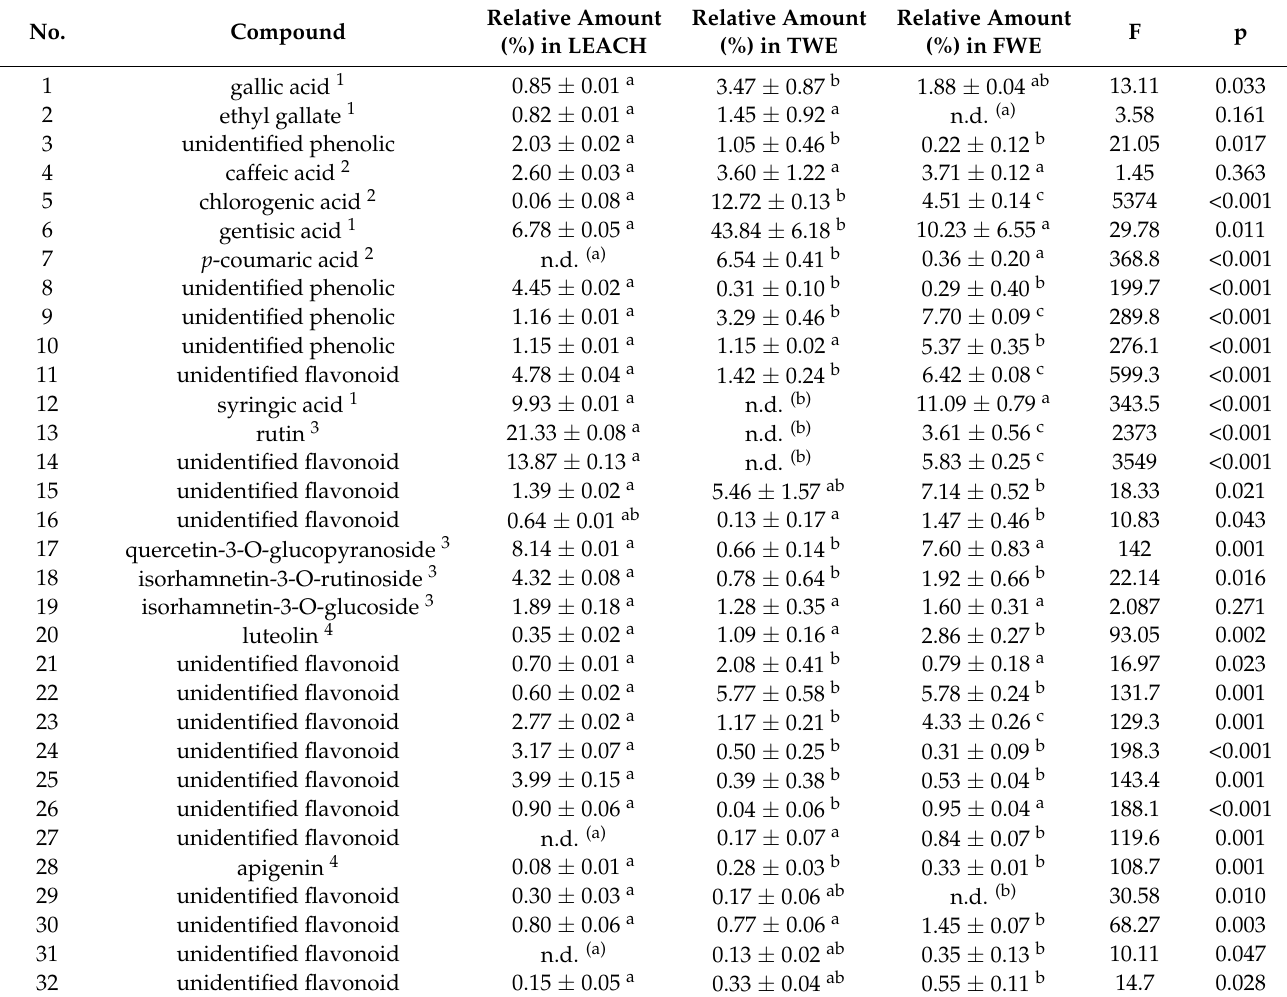
Table 3. Observed differences in the relative composition of 32 phenolic compounds present in the distillation wastewaters (LEACH) and the corresponding distilled straws of inflorescences (TWE and FWE) from Lavandula angustifolia var. Rosa. In Table S1 the same data quantified as µ g/g DW are